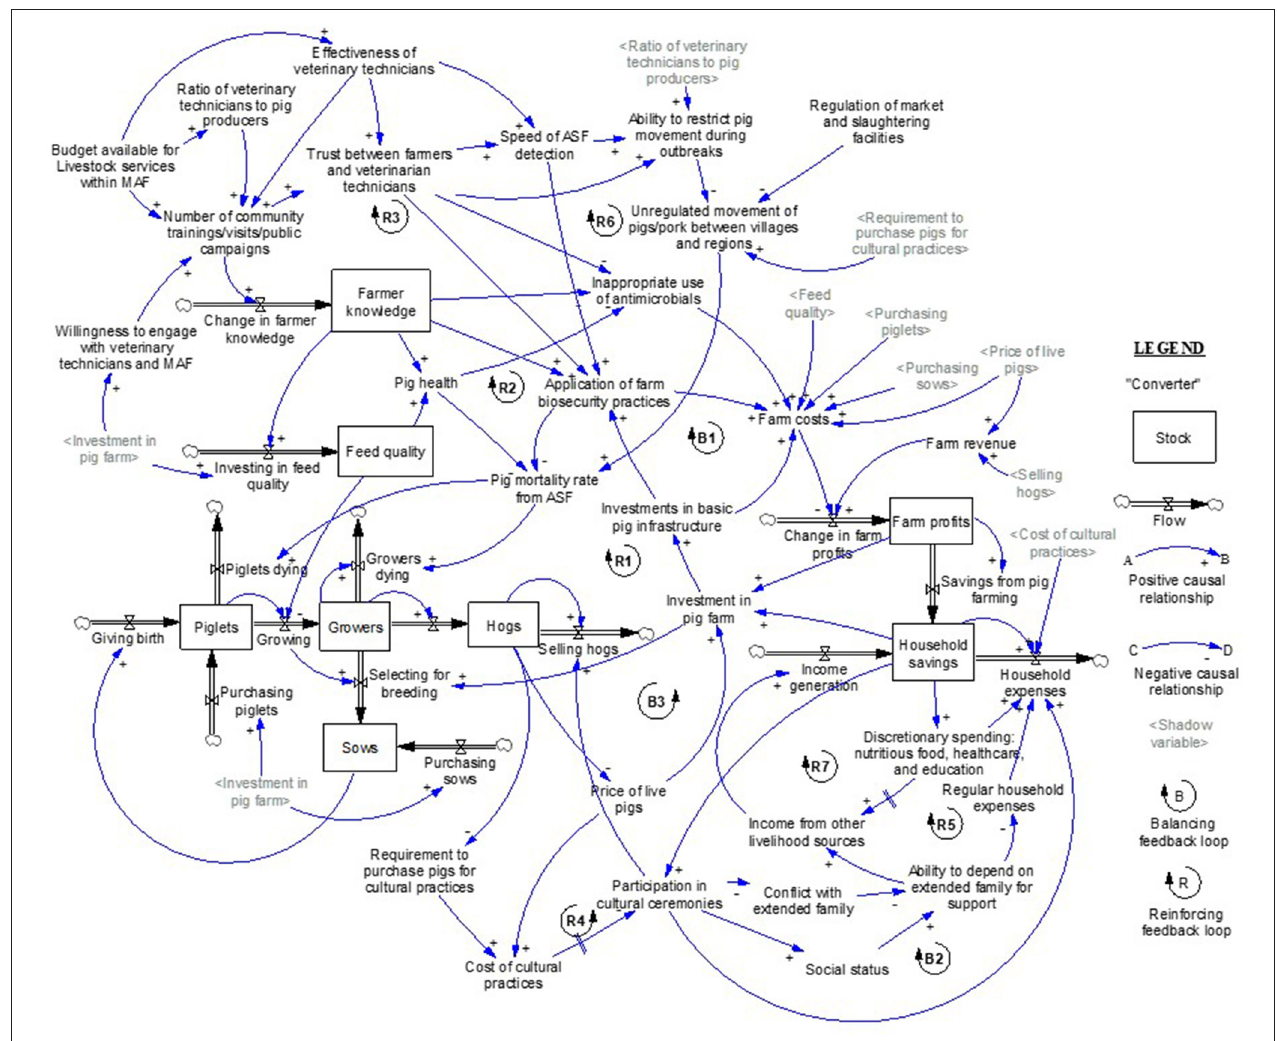
FIGURE 1 | Concept model of the Timor-Leste pig system, including interactions between marketing dynamics, production practices, livelihoods and socio-cultural dimensions, farmer knowledge, and animal health infrastructure. Gray parameters are repeated “shadow” variables from the concept model. “R” indicates reinforcing feedback loops and “B” indicates balancing feedback loops in the system. Unboxed text represents key converters (also known as parameters) in the model while boxed text represents key stocks in the system and black arrows show flows into and out of these stocks. Blue arrows show critical casual relationships between stocks, flows, and converters with the + sign indicates movement in the same direction as the origin of the change and the—sign indicates movement in the opposite direction to the origin of